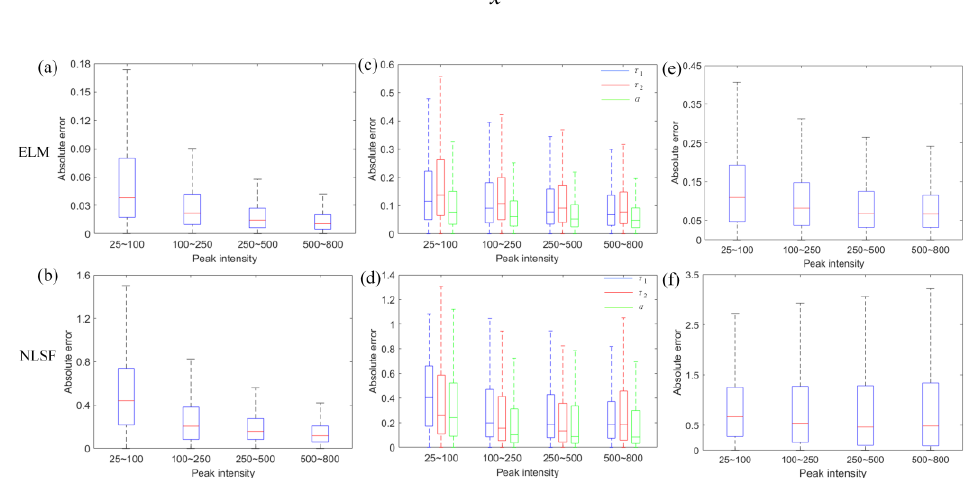
Figure 2. Box plots of absolute error versus different peak intensity levels regarding testing datasets. ( a , b ) Single lifetime estimations of mono-exponential decays from ELM and NLSF, respectively. ( c , d ) Double lifetime estimations of bi-exponential decays from ELM and NLSF, respectively. ( e , f ) τ A estimated by ELM and NLSF, respectively.